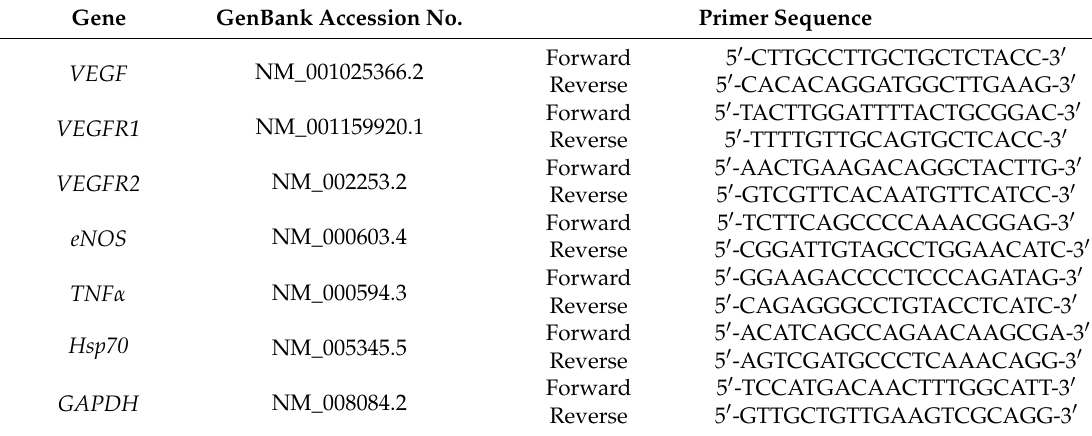
Table 1. Primers used in RT-qPCR